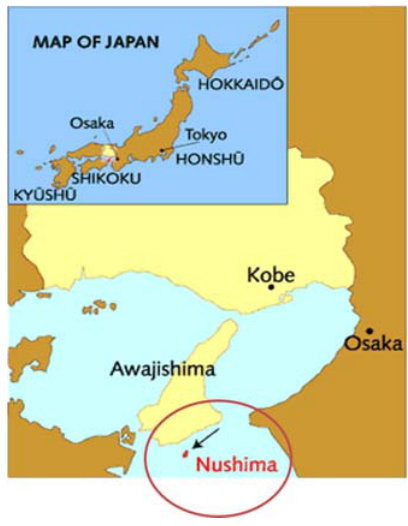
Figure 1. Map of Nushima Island. Source: Thoa et al. [4], originally fromWeb ‐ Japan.org [5].